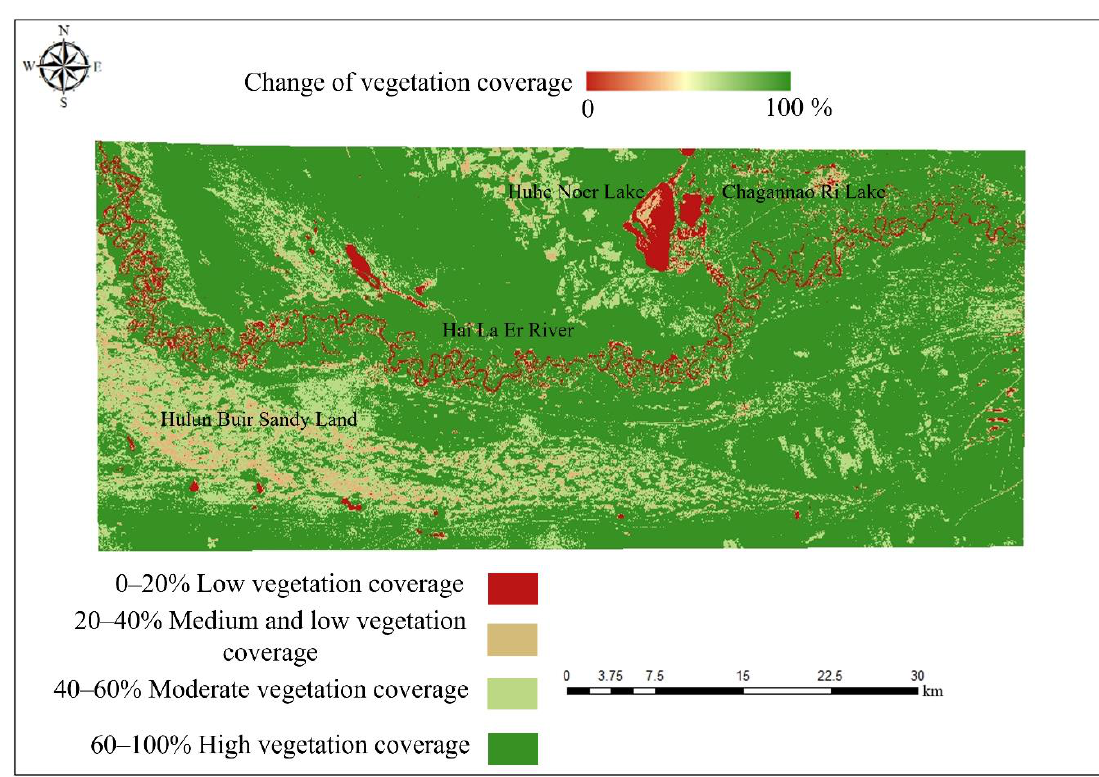
Figure 4. Vegetation coverage in the lower reaches of the Hai La Er River in 1989.